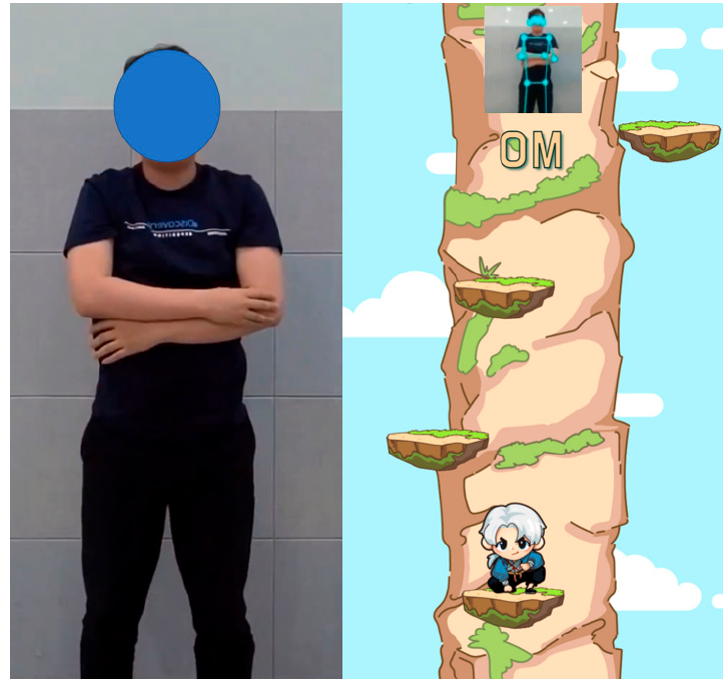
Figure 3. SUKIA intervention.